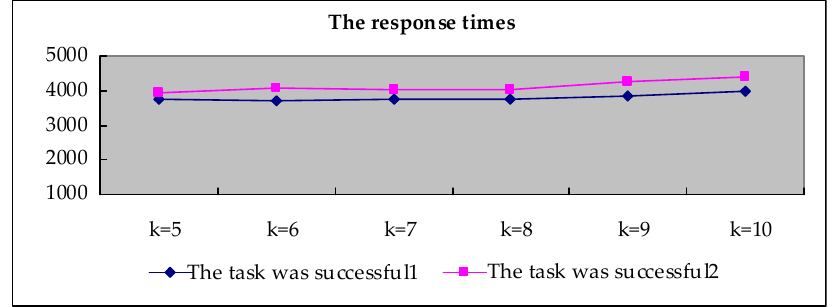
Figure 6. The response times.